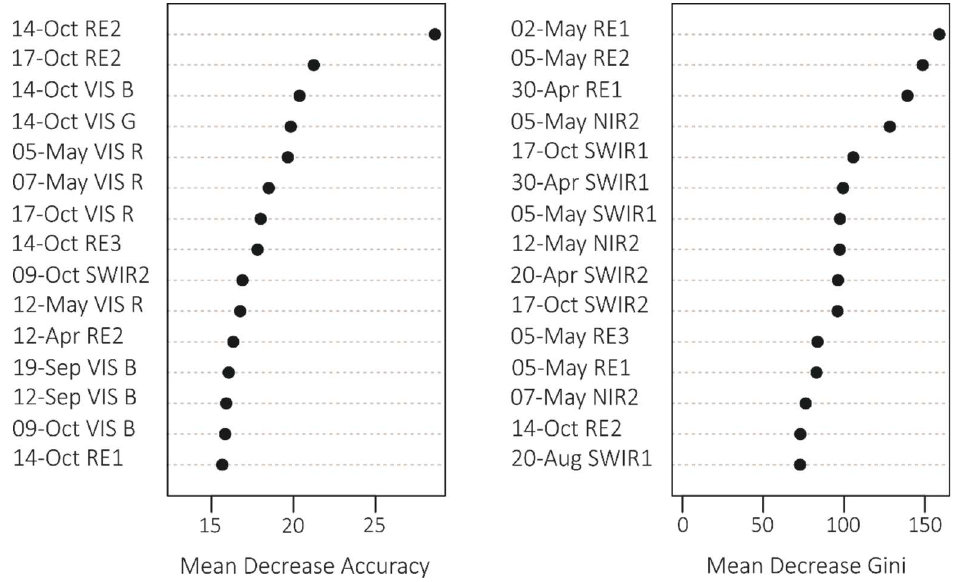
Figure 4. Fifteen most important variables for tree species classification according to Mean Decrease Accuracy and Mean Decrease Gini statistics .